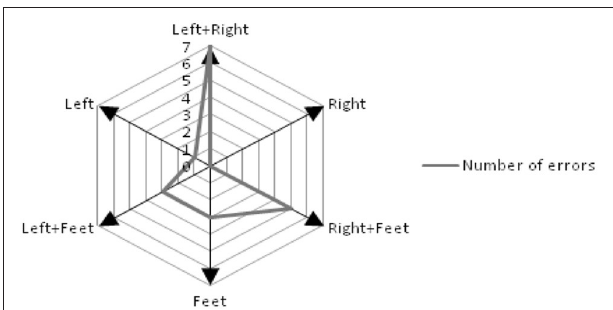
FIGURE 6 | The number of errors for all kinds of motor imagery including left hand motor imagery (Left), right hand motor imagery (Right), feet motor imagery (Foot), left hand and feet motor imagery (Left + Feet), right hand and feet motor imagery (Right + Feet) and left hand and right hand motor imagery (Left +